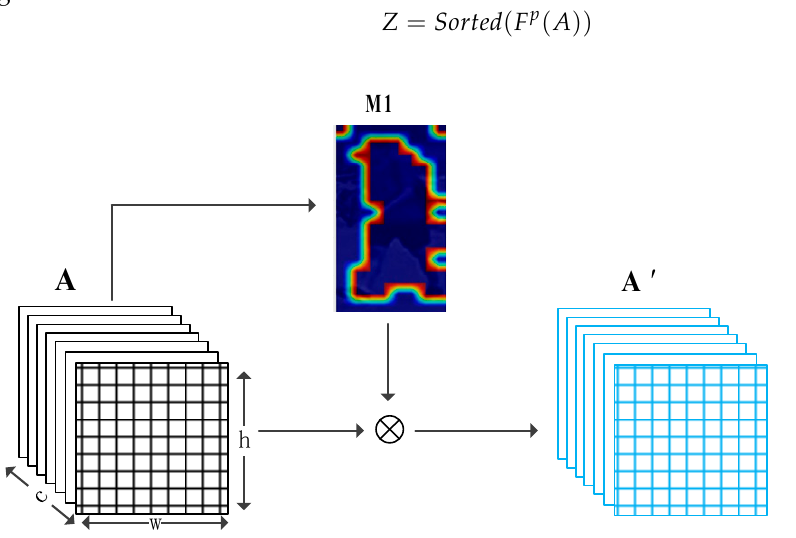
Figure 4. Illustration of M1 generation and deployment, where A represents the output feature of the backbone network, M1 is the background mask generated by A , A’ is the feature after M1 .